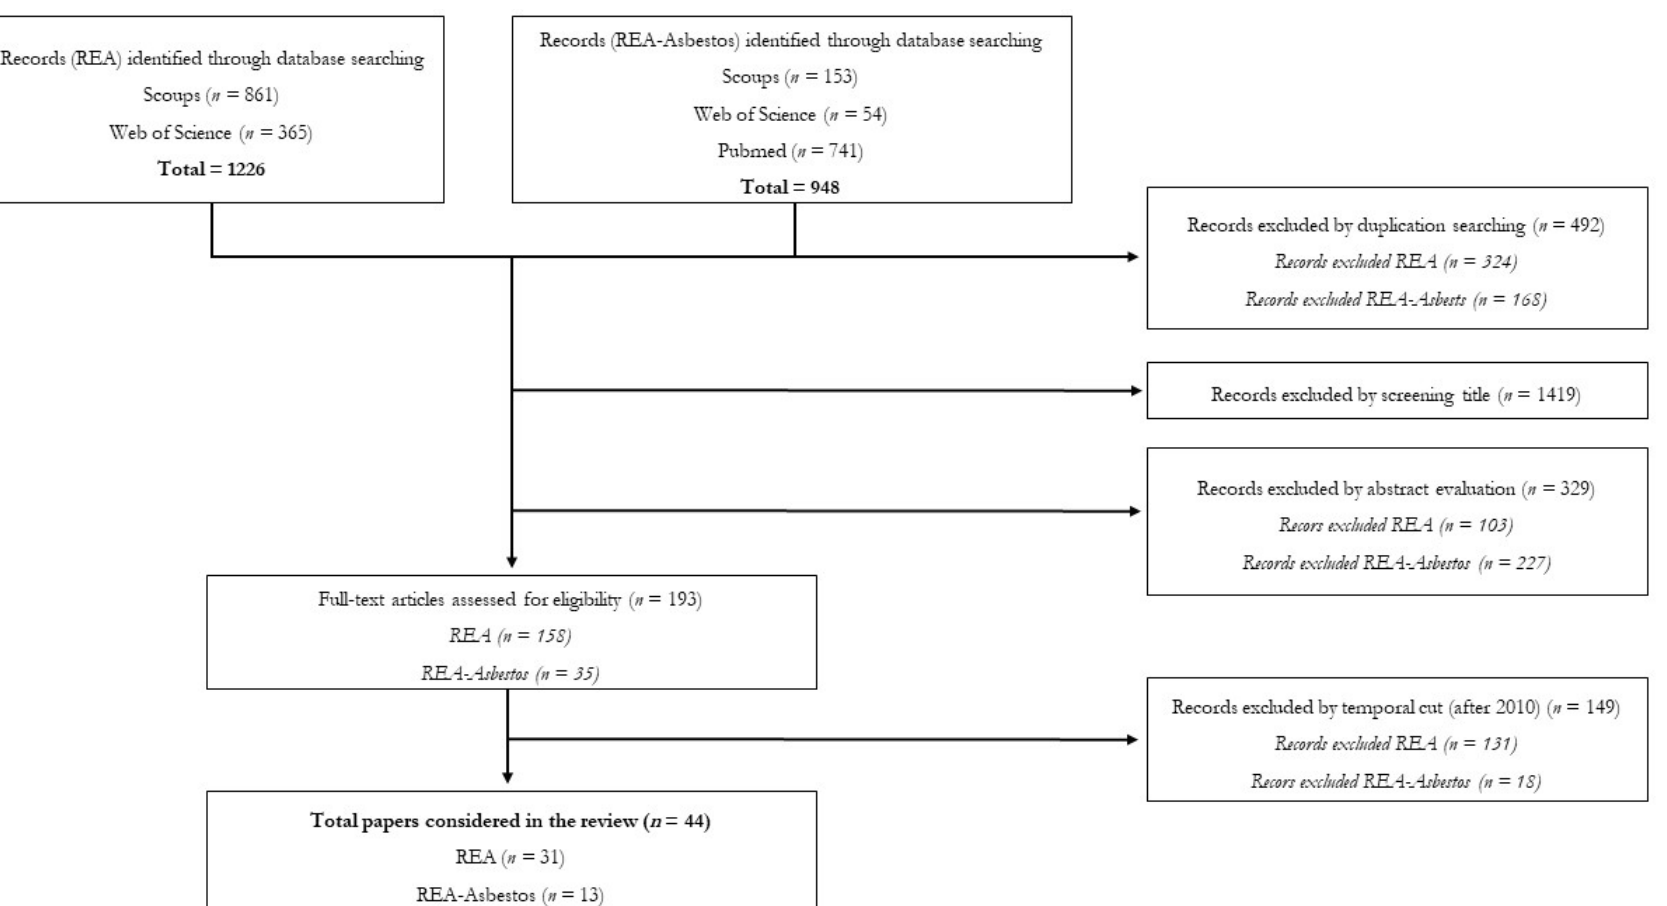
Figure 1. Systematic review flowchart, modified from Moher et al., 2009 [11].